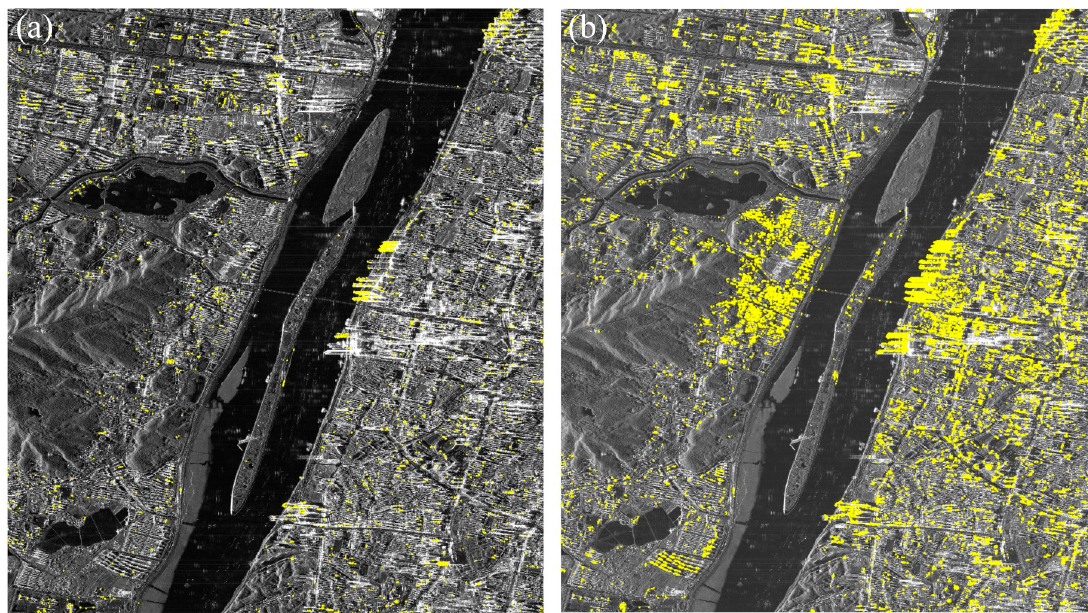
Figure 6. PS and DS candidate distribution. ( a ) PS candidates. ( b ) DS candidates.